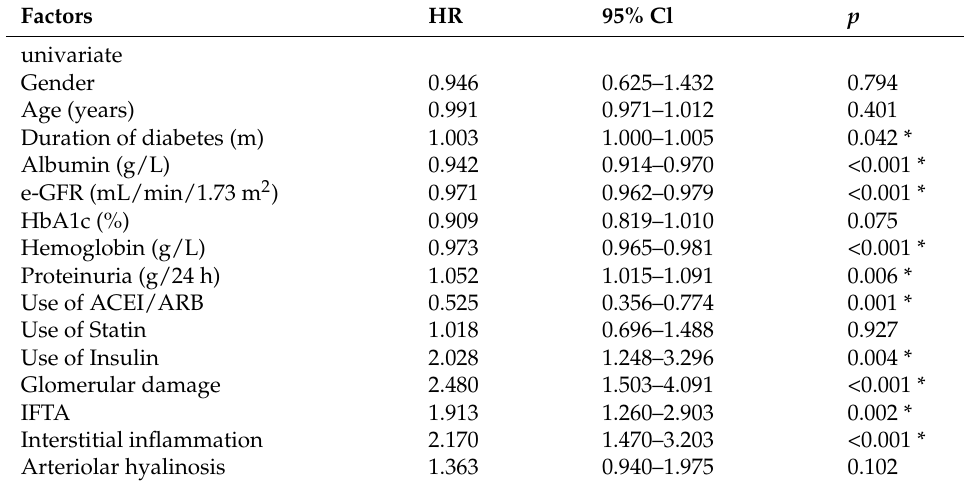
Table 5. Risk factors for ESRD identified by univariate Cox analysis in DKD patients with nephrotic range proteinuria.